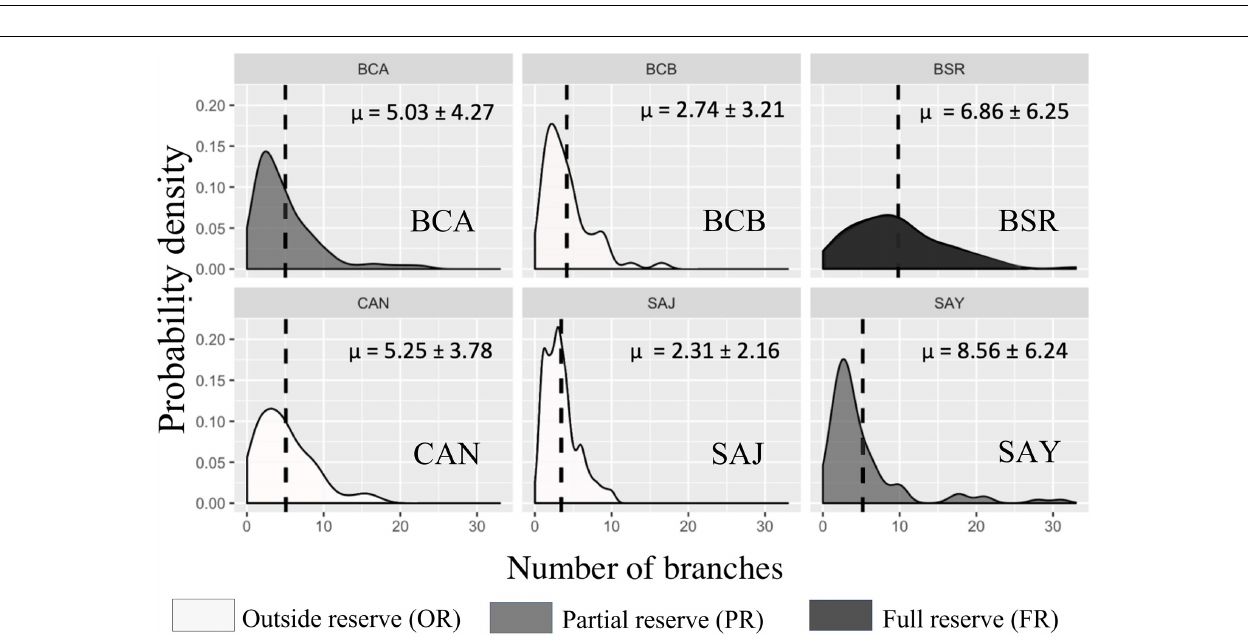
FIGURE 3 | Cerbère-Banyuls reserve: representation of probability density functions by population of each site for the variable number of branches in 2020. The values indicated correspond to the means followed by the standard deviations. In dark the population in full reserve (BSR), in medium the populations in partial reserve (BCA, SAY), in clear the populations outside the reserve (BCB, CAN, SAJ).